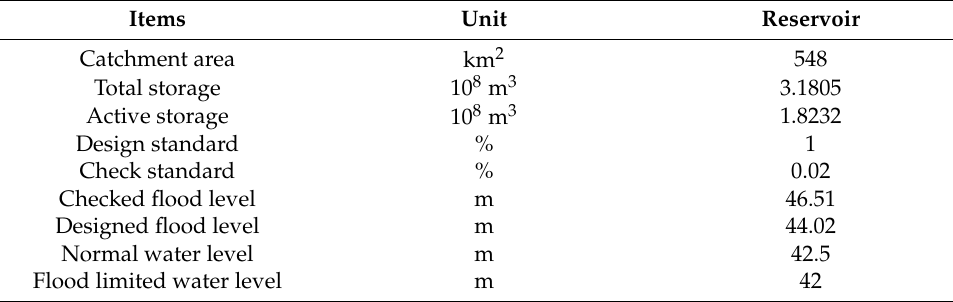
Table 1. Basic parameters of the Rizhao